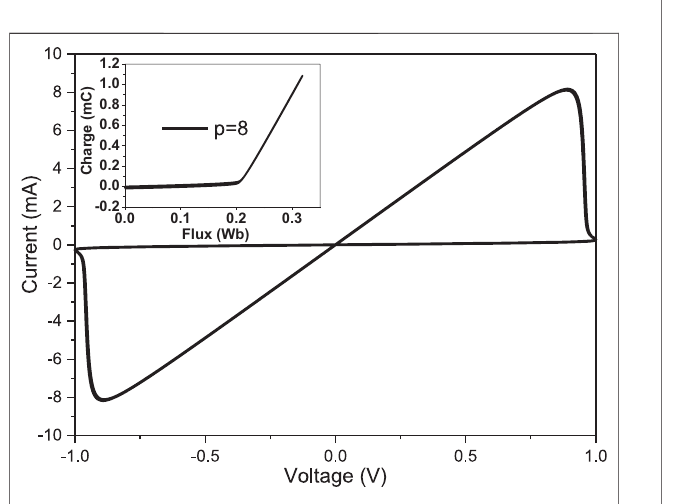
FIGURE5| Calculated i - v characteristic ofourproposed memristor with p (cid:1) 8. The inset is the nonlinear single-valued function between charge and magnetic fl ux. FIGURE 7 | SPICE code of memristor subcircuit for use in